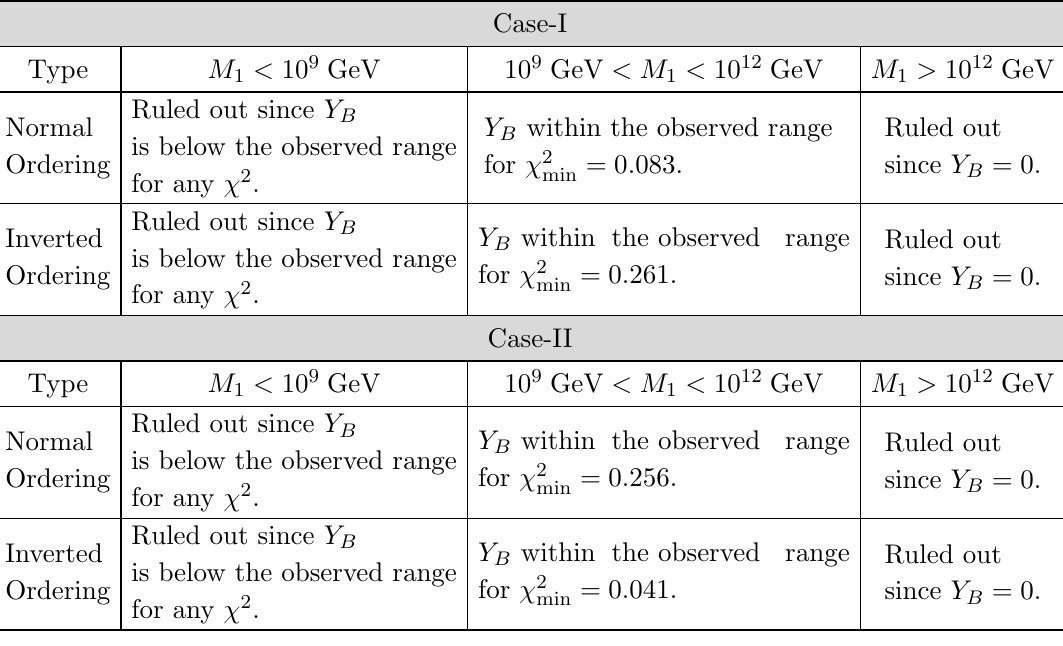
Table 8 . Final statements on Y B for di(cid:11)erent mass